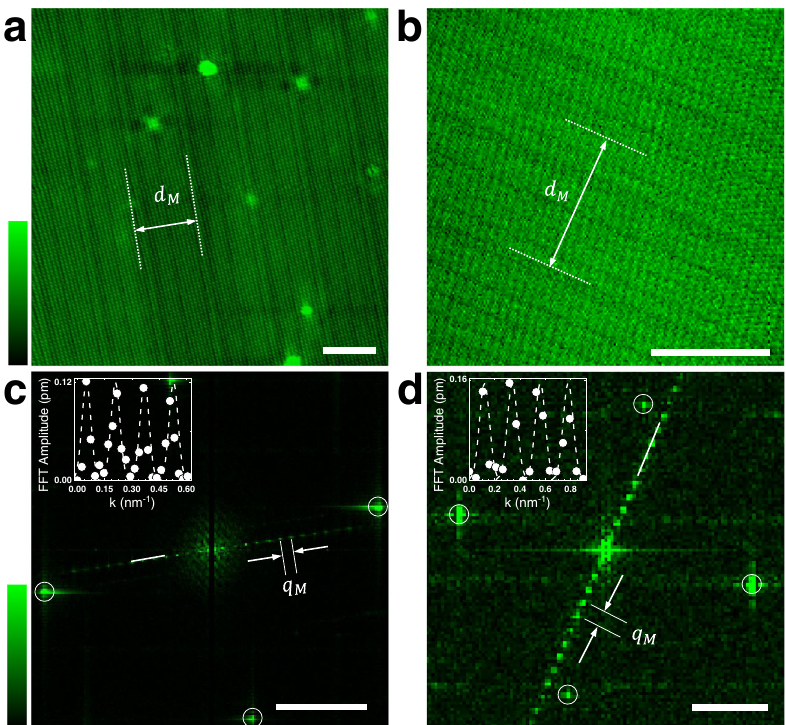
Fig. 2 Moiré patterns in URu 2 Si 2 . a, b Atomic resolution Scanning Tunneling Microscopy (STM) images in two different fi elds of view. Notice that these show the behavior over many atomic lattice constants. We mark the 1D modulation of wavelength d M by dashed lines and the arrow. The current is constant at 0.05 nA and the bias voltage is of 4 mV in left panel and 5 nA and 5 mV in the right panel. The colored bars provide the vertical scale, with 20 pm from black to green in left panel and 37 pm in right panel. Horizontal scale bars are 5 nm long. c, d Fourier transform of the images in a and b , respectively. We observe the usual atomic Bragg peaks due to the square surface atomic lattice and also multiple peaks at reciprocal space distances q M . We mark with white circles the Bragg peaks of the atomic lattice and the wavevector of the modulation q M . Horizontal scale bars are 1.2 nm − 1 long. The Fourier amplitude is given by the vertical bars, with 0.12 pm in left panel and 0.16 pm in right panel, from black to green. Insets show pro fi les of the Fourier amplitude along the white lines in the Fourier transform. White dots are points of the image and the dashed line is a guide to the eye. Similar d M are obtained in 24 different fi elds of view acquired in 5 different samples. We show further details of the modulation in the Supplementary Notes 1, 2, 5, 6, and 8 and Supplementary Figs. 1, 3, 6, 9, 10, and